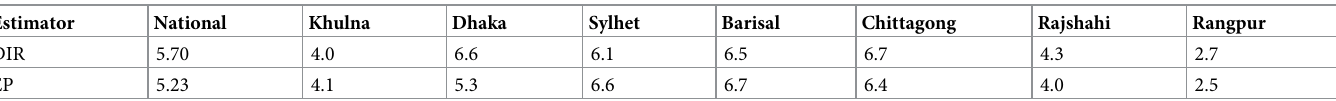
Table 4. Aggregated level estimates of diarrhoea prevalence (%) generated by direct (DIR) and model-based (EP) method. Estimator National Khulna Dhaka Sylhet Barisal Chittagong Rajshahi Rangpur DIR